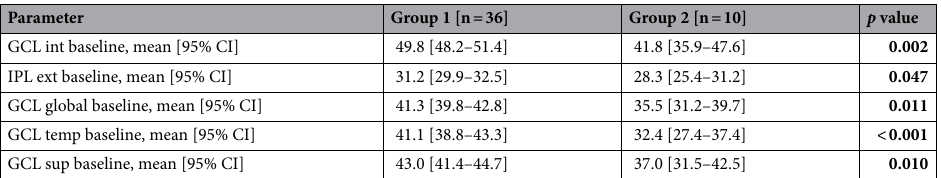
Table 2. Baseline thickness of retinal layers with significant difference between groups. Group 1 = non vitrectomized; Group 2 = vitrectomized; GCL = Ganglion cell layer; IPL = inner plexiform layer; int = inner ring ETDRS subfields; ext = outer ring ETDRS subfields; global = the nine ETDRS subfields; temp = inner and outer temporal ETDRS subfields; sup = inner and outer superior ETDRS subfields. 95% CI = 95% Confidence interval. Only statistically significant differences are reported. All significant values are represented in bold. A p < 0.05 was considered statistically significant.